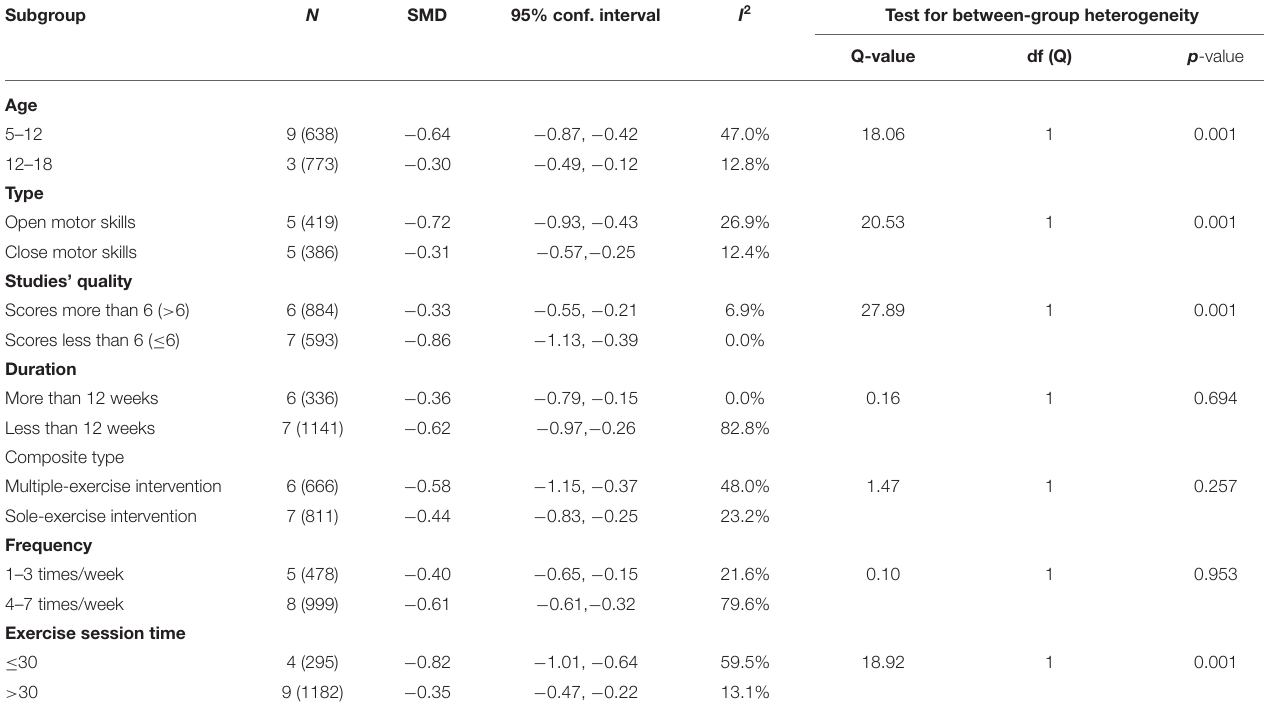
TABLE 6 | Subgroup analysis of working memory (chronic exercises).